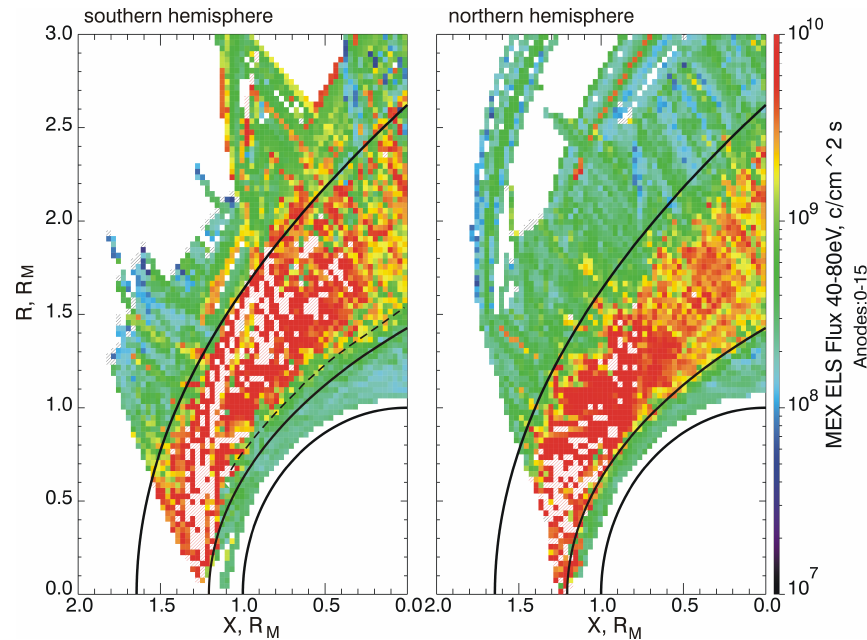
Fig. 1. Maps of total median electron fluxes (40eV <E< 80eV) on the dayside for the Northern and Southern Hemispheres at the range of longitudes 130 ◦ < Long < 240 ◦ . Solid curves show statistical average positions of the magnetospheric boundary (MB) (Dubinin et al., 2006) and the bow shock (BS) (Vignes et al., 2000). Dashed curve gives a shift of the MB above the crustal magnetic sources.